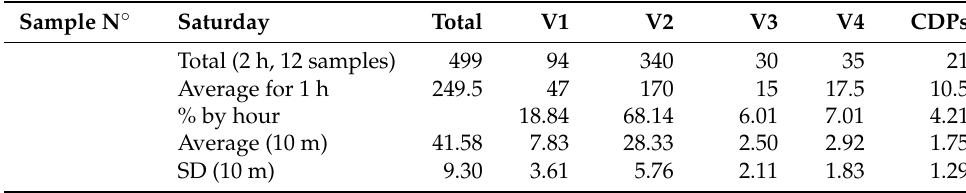
Table 4. Saturday sample resume.